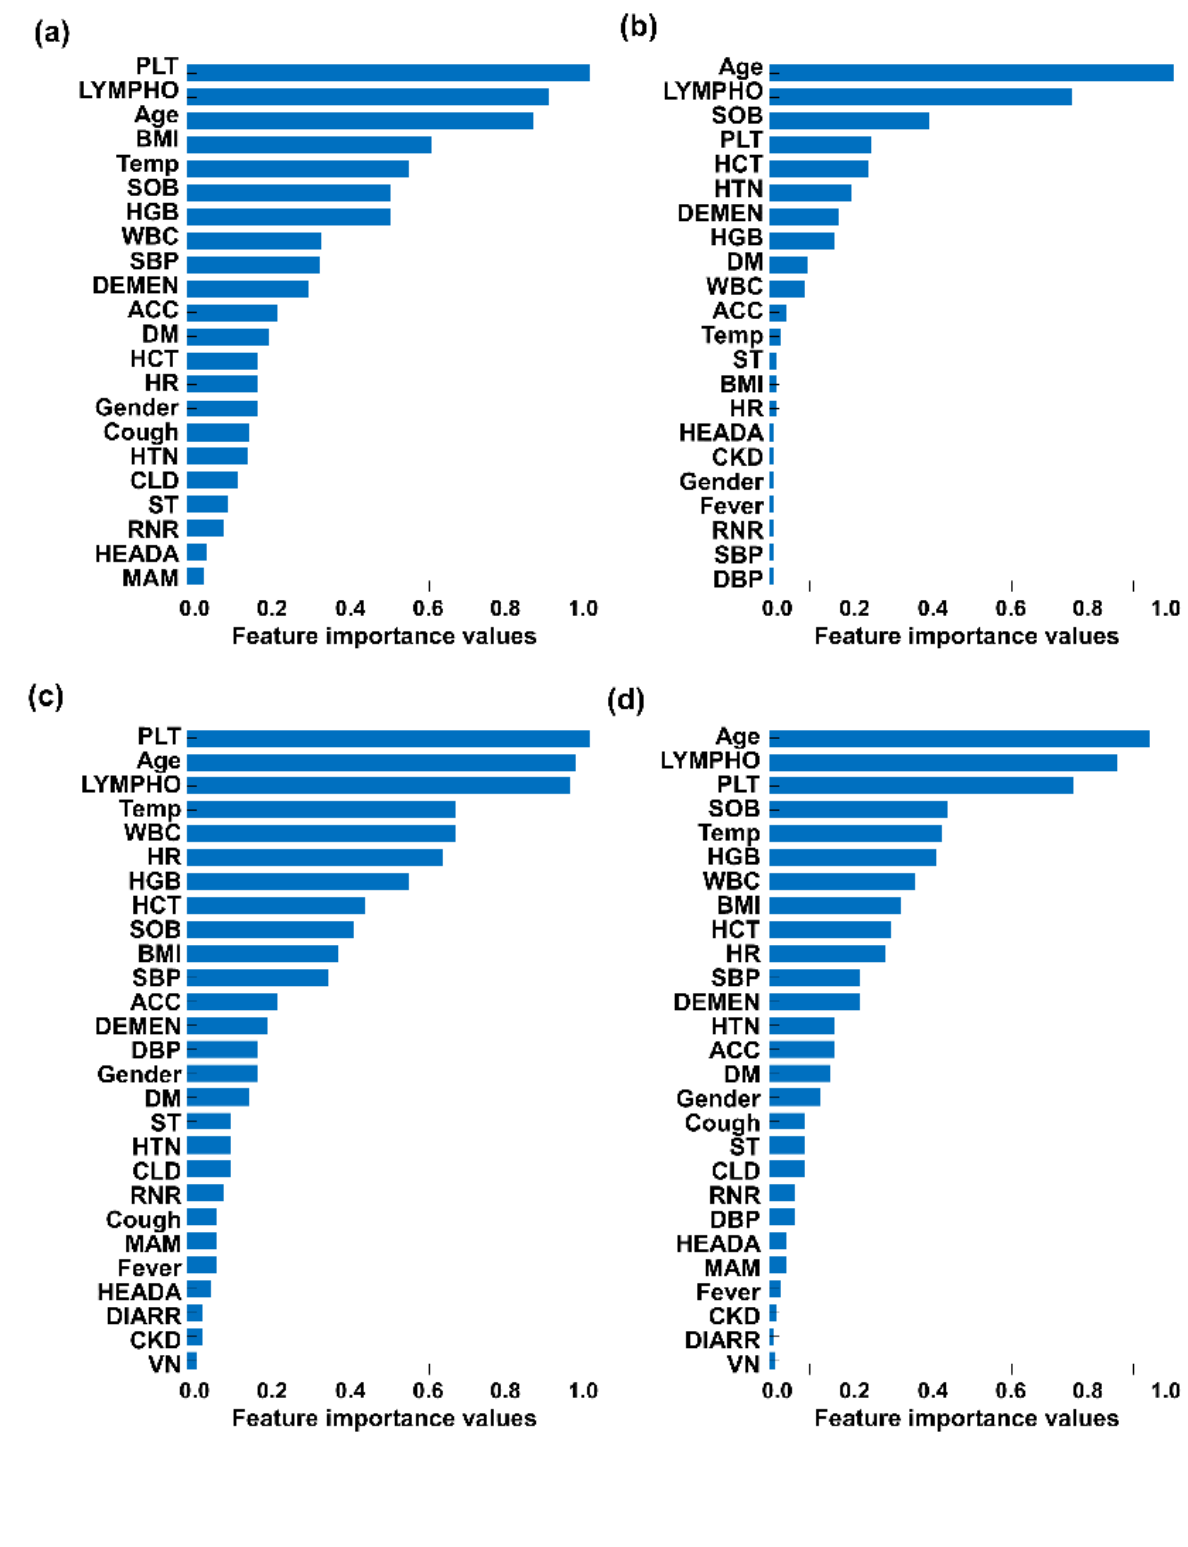
Figure 1. Results of normalized feature importance analysis from (a) AdaBoost, (b) random forest, and (c) eXtreme Gradient Boosting (XGBoost) as well as (d) the combined average ranked feature importance. ACC: altered consciousness/confusion; BMI: body mass index; CCD: chronic cardiac disease; CKD: chronic kidney disease; CLD: chronic liver disease; COPD: chronic obstructive pulmonary disease; DBP: diastolic blood pressure; DEMEN: dementia; DIARR: diarrhea; DM: diabetes mellitus; FM: fatigue/malaise; HCT: hematocrit; HEADA: headache; HF: heart failure; HGB: hemoglobin; HR: heart rate; HTN: hypertension; LYMPHO: lymphocyte; MAM: muscle aches/myalgia; PLT: platelets; Preg: pregnancy; PregWk: pregnancy weeks; RDAD: rheumatism/autoimmune disease; RNR: runny nose/rhinorrhea; SBP: systolic blood pressure; SOB: shortness of breath/dyspnea; SPUTUM: sputum production; ST: sore throat; Temp: temperature; VN: vomiting/nausea; WBC: white blood